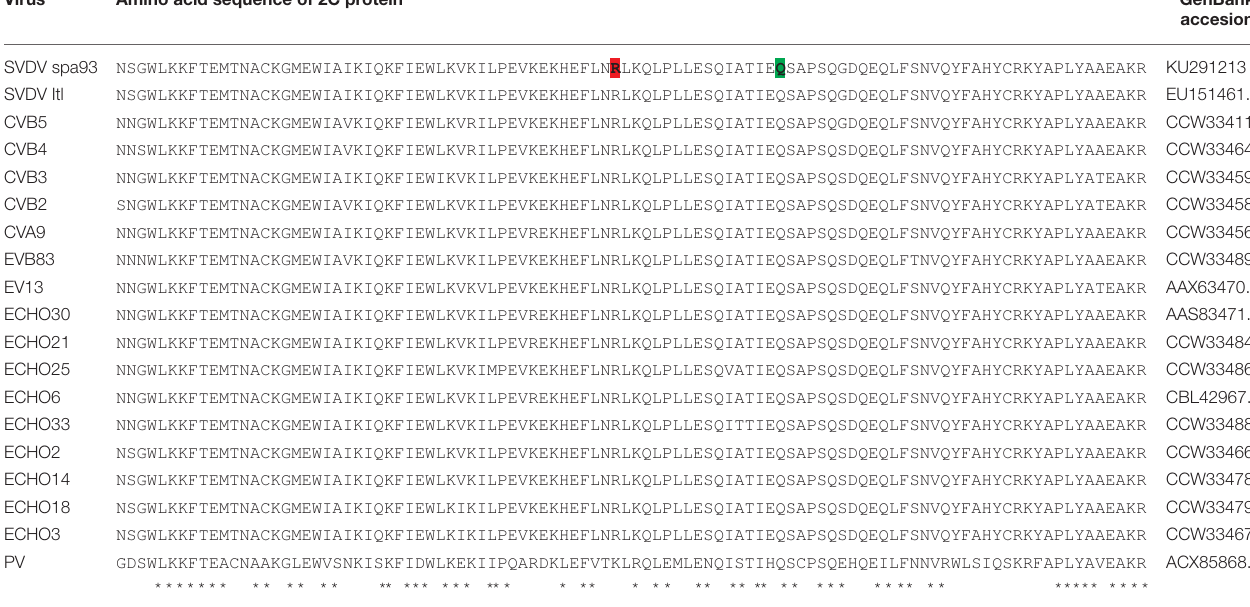
TABLE 3 | Representative multiple sequence alignment of 2C proteins from different enterovirus and the SVDV strain used in this work (SVDV SPA/1/ ′ 93). Virus Amino acid sequence of 2C